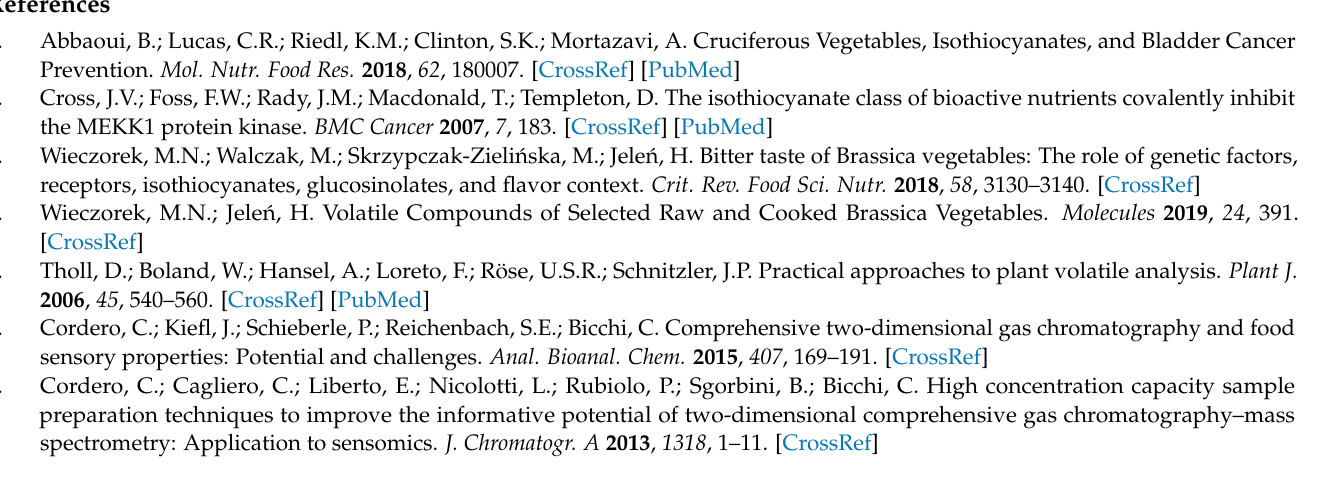
Figure S1. Compounds extracted by SPME, characteristic for fresh and frozen-thawed broccoli florets. Figure S2. Average values of geometric parameters together with standard deviations for imaging from the parenchymatic tissue area. Figure S3. Average values of geometric parameters together with standard deviations for imaging from the epidermal tissue area. Figure S4. The scheme of enzymes activity assay experiment. Figure S5. SPME extraction parameters investigated for sampling of broccoli volatiles. Table S1. Metabolites identified in fresh and frozen-thawed florets of broccoli using SPME-GCxGC-ToFMS. Table S2. The mean values and standard deviations of the measured geometric parameters for all sample treatment methods for imaging from the parenchymatic tissue area. Table S3. The mean values and standard deviations of the measured geometric parameters for all sample treatment methods for imaging from the epidermal tissue area. Table S4. Influence freezing- thawing of broccoli florets on extracted volatiles. Table S5. Influence of broccoli florets preparation on the amount of extracted volatiles by SPME. Table S6. Statistical results for the comparison of sample pairs Table S7. Influence of enzymatic reactions quenching in broccoli florets on extracted volatiles. Table S8. Statistical results for the comparison of sample